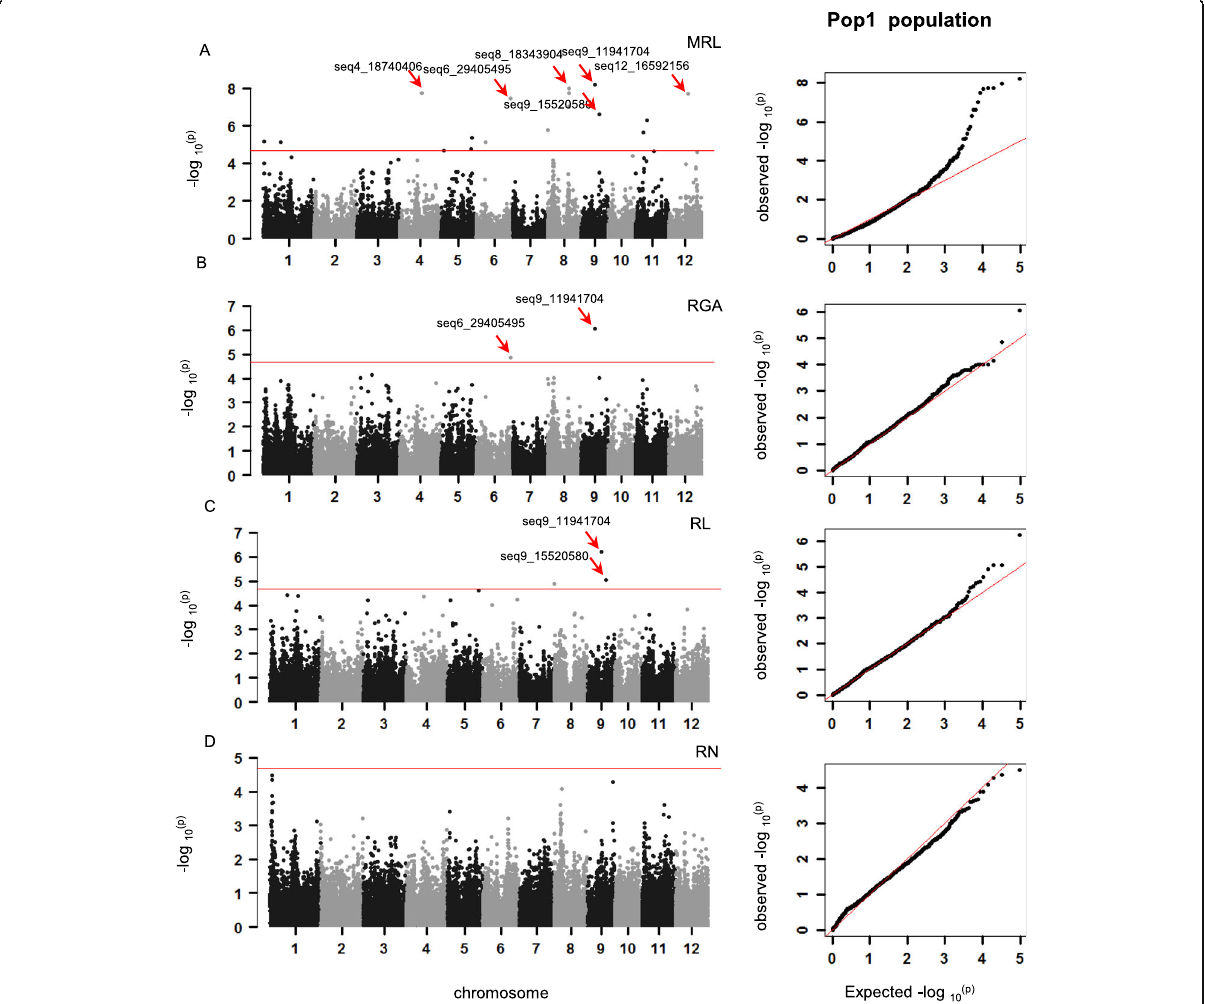
Fig. 3 GWAS for rooting ability – related traits in the Pop1 association panel. Manhattan plots and quantile-quantile plots for MRL ( a ), RGA ( b ), RL ( c ), RN ( d ). The red line in the manhattan plot represents the significance threshold. The red straight line in the quantile-quantile plot represents expected null distribution of p -value and black dots represent observed distribution of p -values. MRL: maximum root length, RGA: root growth ability, RL: root length, RN: root